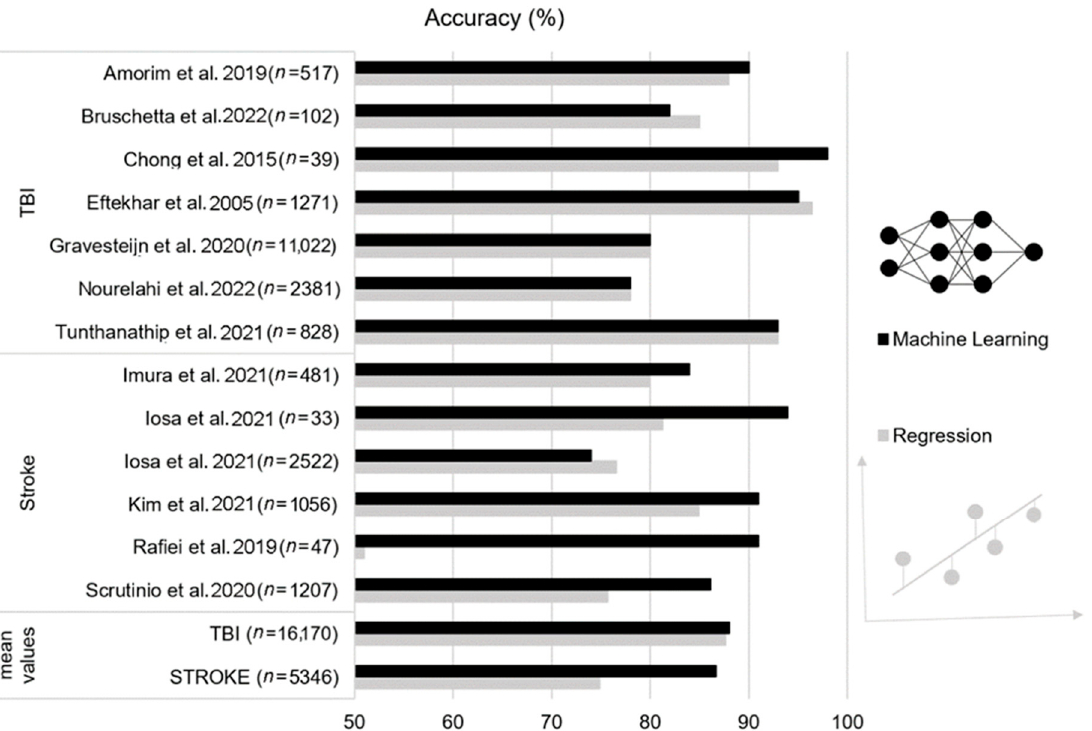
Figure 1. Accuracy (%) of outcome prediction in traumatic brain injury (TBI) and stroke patients for the considered studies ( n: sample size). Machine learning approach (black bars) versus linear regression (grey bars), [17–29].